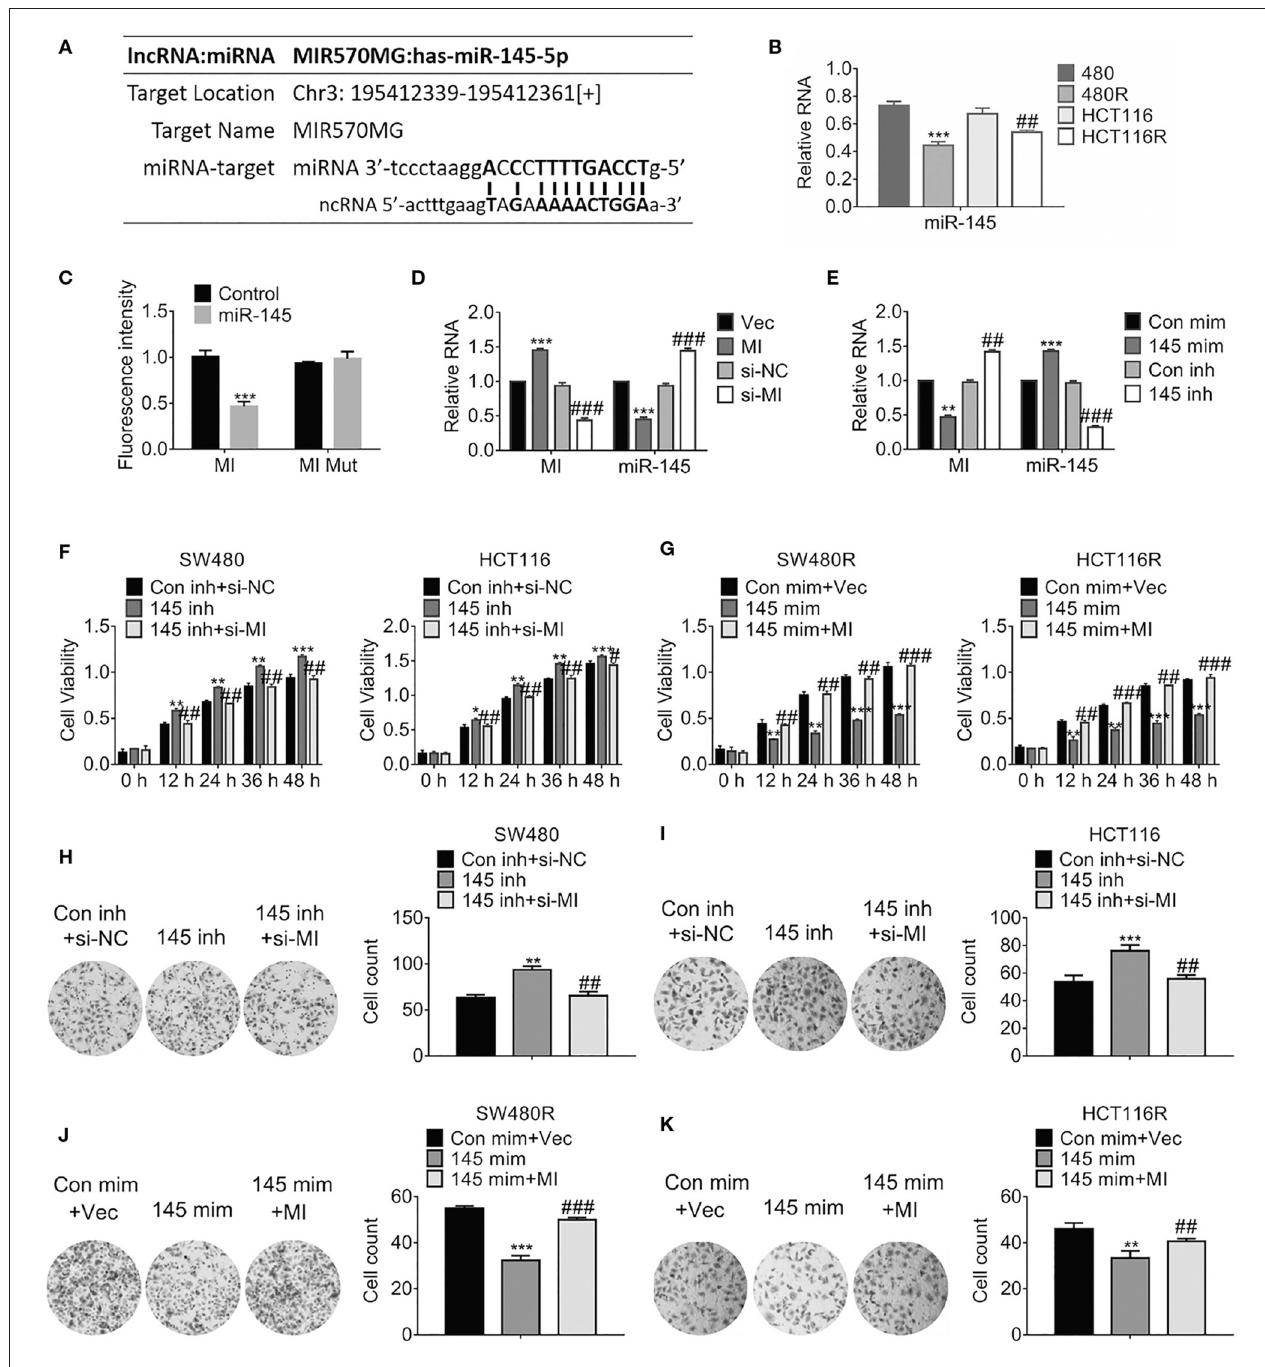
FIGURE 3 | MIR570MG sponges miR-145 and reverses miR-145-mediated growth suppression. (A) Schematic diagram of putative binding sites between MIR570MG and miR-145. (B) Expression of miR-145 in the indicated cell lines. ** P < 0.01, vs. SW480; ## P < 0.01, vs. HCT116. (C) Dual-luciferase activity of miR-145 promoter. MI, wild type MIR570MG; MI Mut, MIR570MG mutant. *** P < 0.001, vs. control. (D) Expression of the indicated RNA in cells expressing MIR570MG or si-MIR570MG. *** P < 0.001, vs. vector; ### P < 0.001, vs. si-negative control. (E) Expression of the indicated RNA in cells expressing miR-145 mimic or miR-145 inhibitor. ** P < 0.01, *** P < 0.001, vs. control-mimic; ## P < 0.01, vs. control-inhibitor. (F) Viability of SW480 and HCT116 cells was accessed by MTT assay at the indicated time-points. * P < 0.05, ** P < 0.01, *** P < 0.001, vs. control; # P < 0.05, ## P < 0.01, vs. miR-145 inhibitor. (G) Viability of SW480R and HCT116R cells was accessed by MTT assay at the indicated time-points. ** P < 0.01, *** P < 0.001, vs. control; ## P < 0.01, ### P < 0.001, vs. miR-145 mimic. (H,I) Colony formation of the indicated cells expressing miR-145 inhibitor or miR-145 inhibitor combined with si-MIR570MG. ** P < 0.01, vs. control; ## P < 0.01, vs. miR-145 inhibitor. (J,K) Colony formation of the indicated cells expressing miR-145 mimic or miR-145 mimic combined with MIR570MG. *** P < 0.001 vs. control; ## P < 0.01 vs. miR-145 mimic. Data represents mean ± SD of three individual experiments. Vec, vector; MI, MIR570MG; si-NC, negative control; si-MI, si-MIR570MG; Con mim, control mimic; 145 mim, miR-145 mimic; Con inh, control inhibitor; R, Reg, 1 µ M regorafenib exposure.